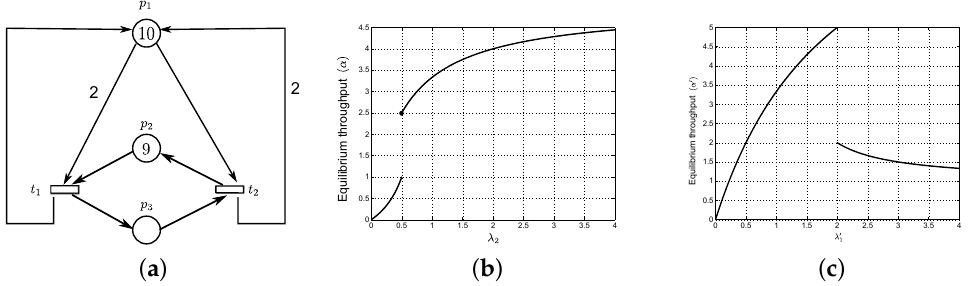
Figure 8. An MTS net, its equilibrium throughput when λ 2 varies (Figure 8b), and its equilibrium throughput when λ 1 varies (Figure 8c). Note that the first one is monotone and the last one is non- monotone. ( a ) An MTS net. The firing of t 1 reduces the tokens in p 1 , while the firing of t 2 increases its value. ( b ) Equilibrium throughput with respect to λ 2 of the net system in Figure 8a. ( c ) Equilibrium throughput with respect to λ (cid:48) constructed using the time-scale property. A non-monotonicity is 1 discovered from a discontinuity in the equilibrium throughput.